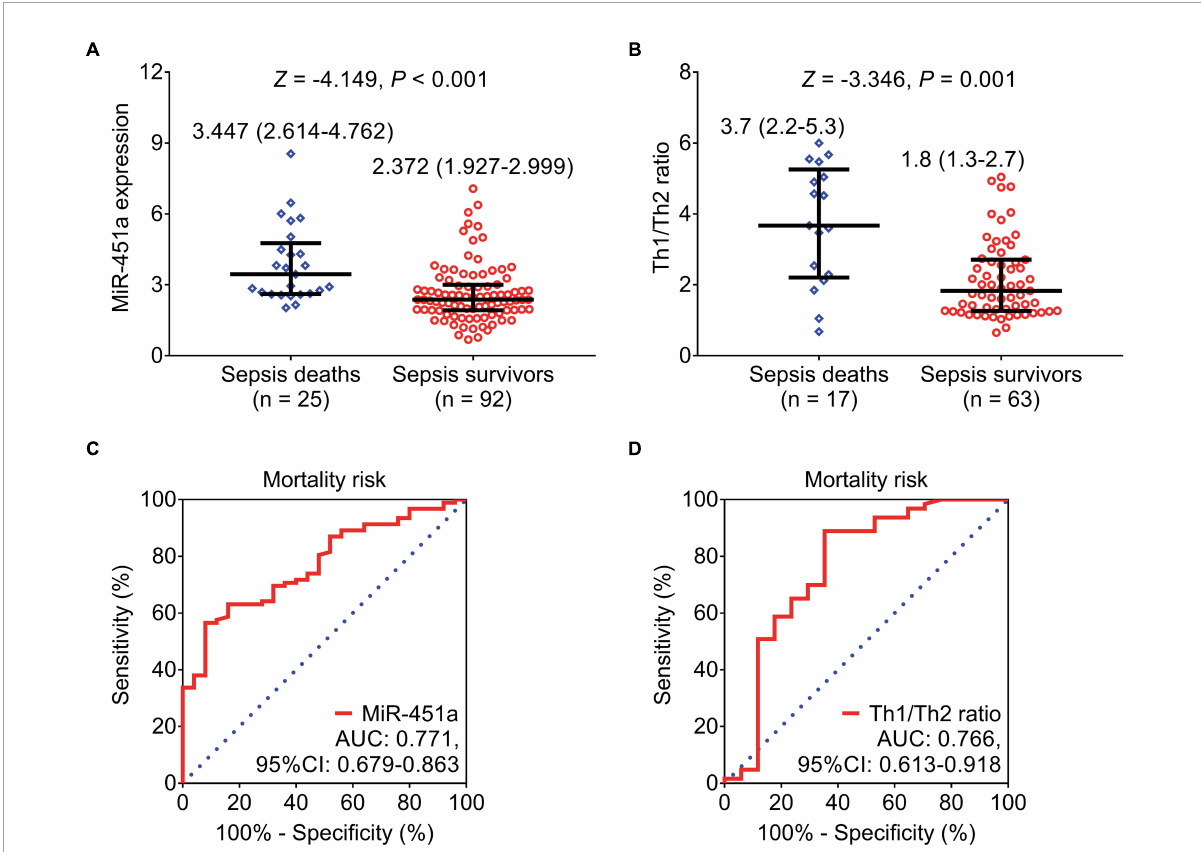
FIGURE4 MiR-451a and the Th1/Th2 ratio could estimate mortality risk. Comparison of miR-451a (A) and the Th1/Th2 ratio (B) between sepsis survivors and sepsis deaths. ROC curve analyses of miR-451a (C) and the Th1/Th2 ratio (D) in estimating mortality risk in patients with